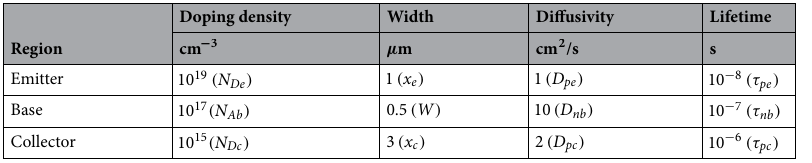
Table 2. Parameters used for each region of the n - p - n transistor. Note: (1) the collector is part of the leg body so as to have the same doping density as the thermoelectric leg. (2) the parameter symbol is in the parenthesis following the parameter value.